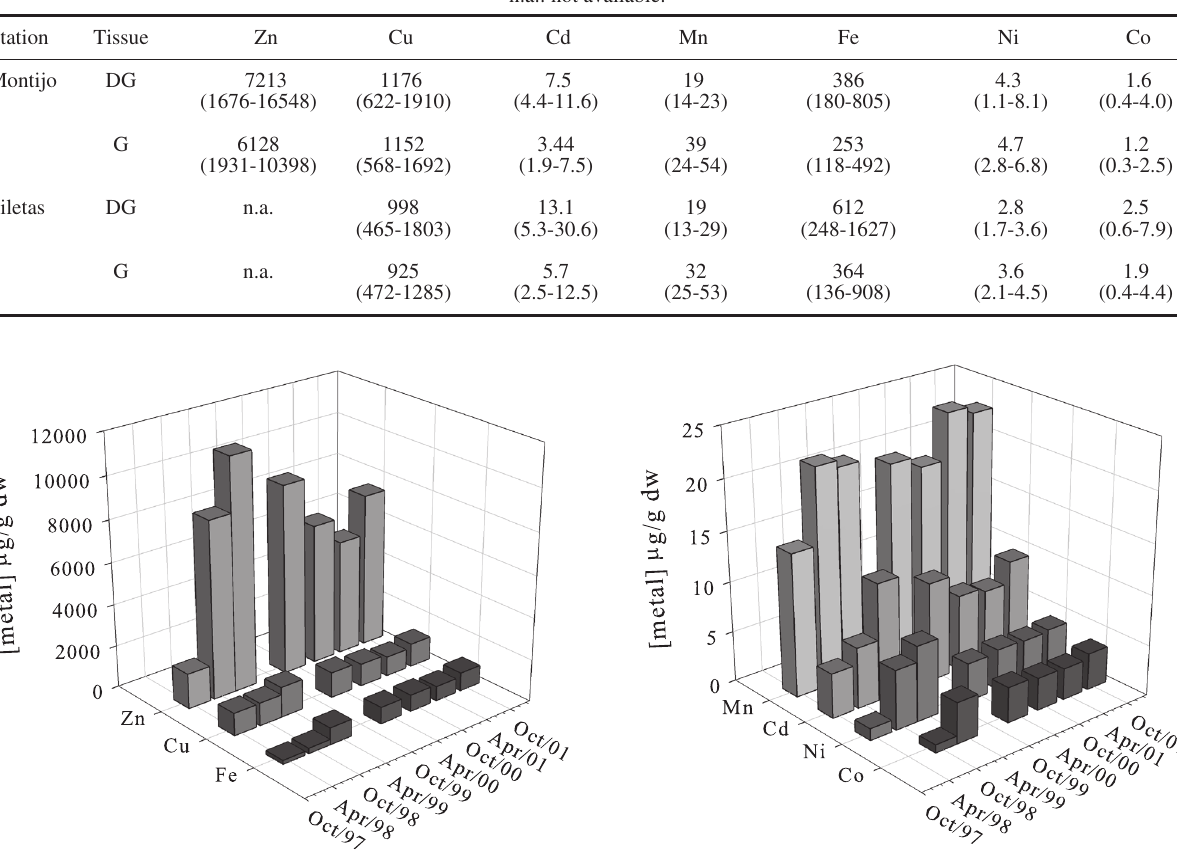
Table 1. – Average and range (in brackets) (µg/g dry weight) of metal concentrations in the digestive gland and gills of oysters from the two stations. These data represent the sum of S1 and P1. No data for Zn are available for the Piletas station. DG: digestive gland; G: gills; n.a.: not available.